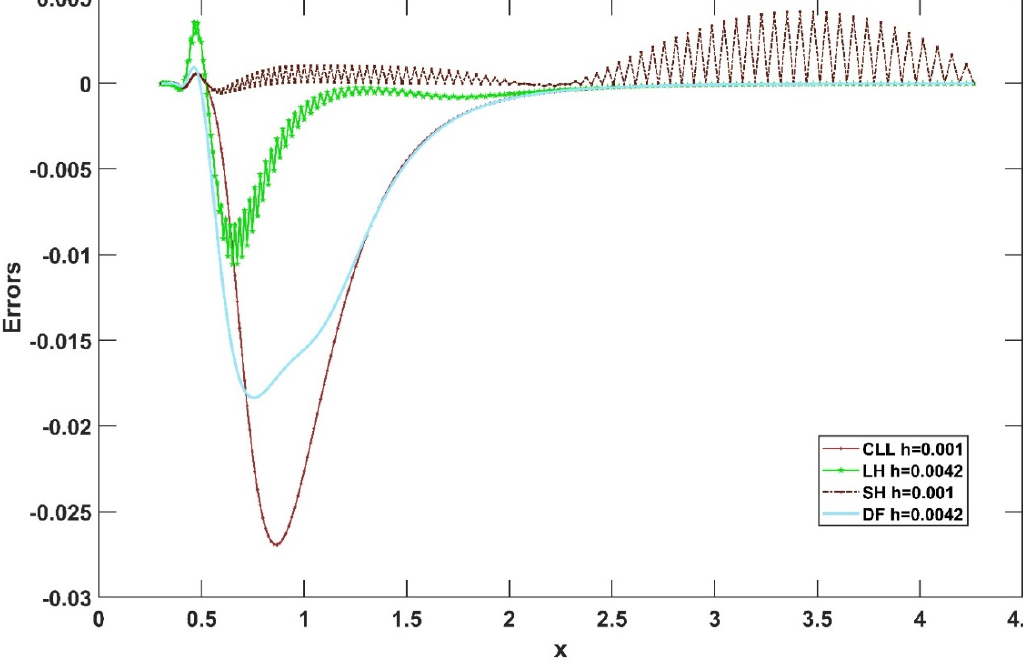
Figure 17. The difference between the analytical solution and the CLL method for 3 1 0 10 h . − = ⋅ as a function of space and time for Experiment 5.